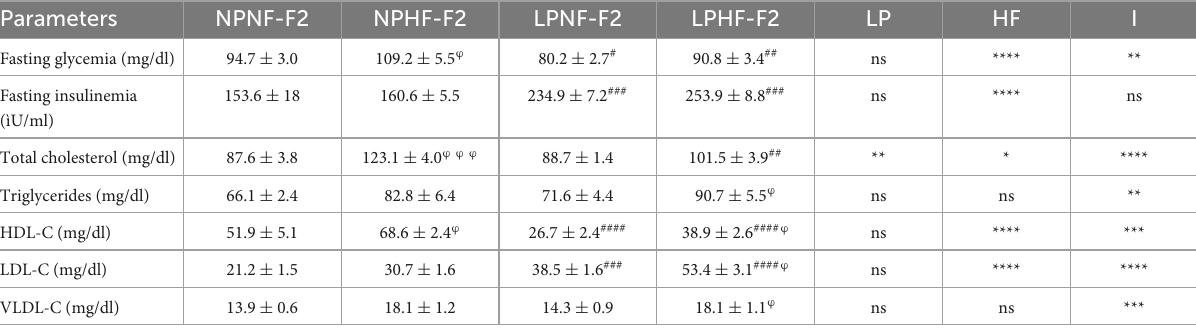
TABLE 1 Effect of high fat (HF) consumption on biochemical parameters at PND90 of adult F2 offspring from F1 dams programmed by protein restriction on lactation. Parameters NPNF-F2 Fasting glycemia